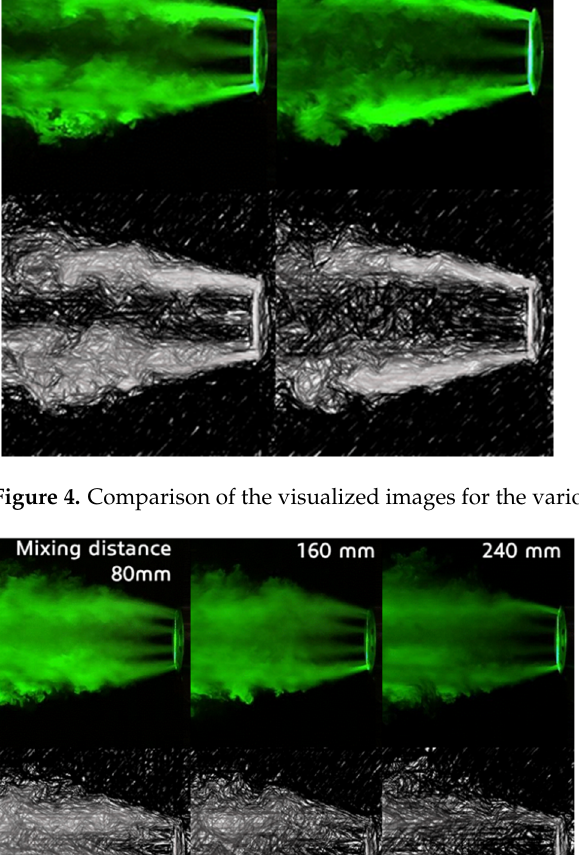
Figure 4. Comparison of the visualized images for the various mixing distances. (“b” nozzle).